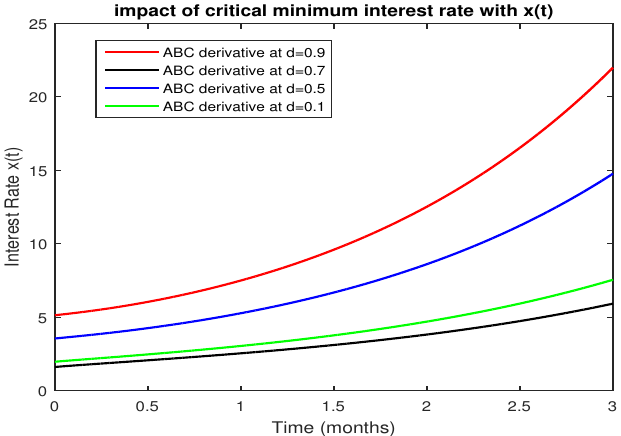
Figure 11. Impact of critical minimum interest rate with x ( t ) .